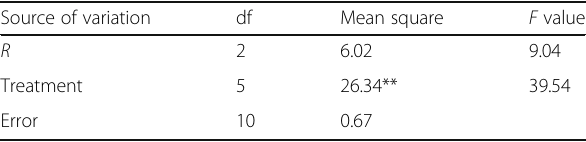
Table 3 Analysis of variance of mortality percentage of Agrotis segetum in different concentrations of Steinernema carpocapsae IRMoghan